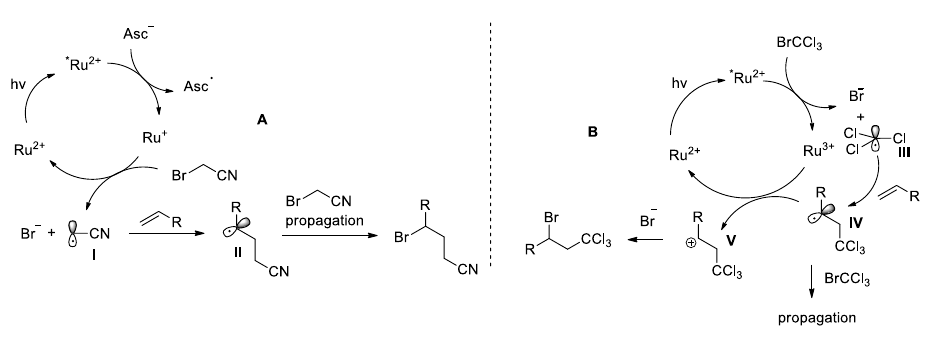
Scheme 8. Proposed reaction mechanism.